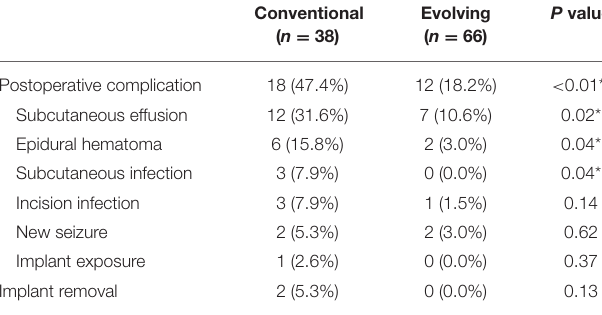
TABLE 1 | General information of patients received two paradigms. TABLE 2 | Incidence of postoperative complications in two